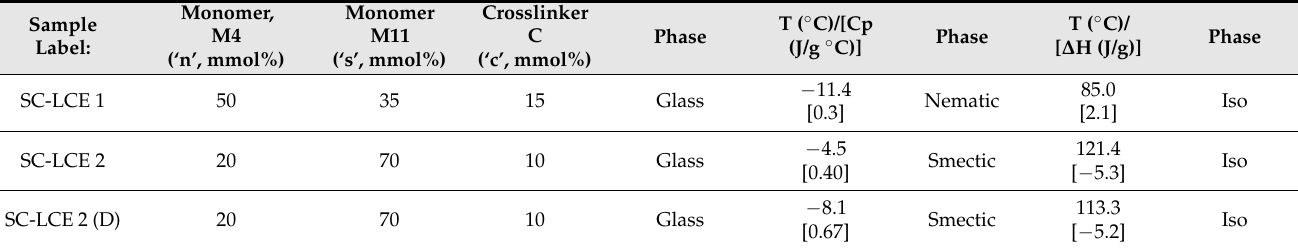
Table 2. Mesophase transitions determined by DSC (cooling rate of 5 °C/min) of the samples labelled ‘ SC-LCE 1 ′ , ‘ SC-LCE 2 ′ , and ‘ SC-LCE 2 ( D )’. Temperature transitions (T, °C), transition enthalpy ( Δ H, J/g), and thermal capacity (Cp, J / g °C) are reported. All values correspond to the second cooling run.